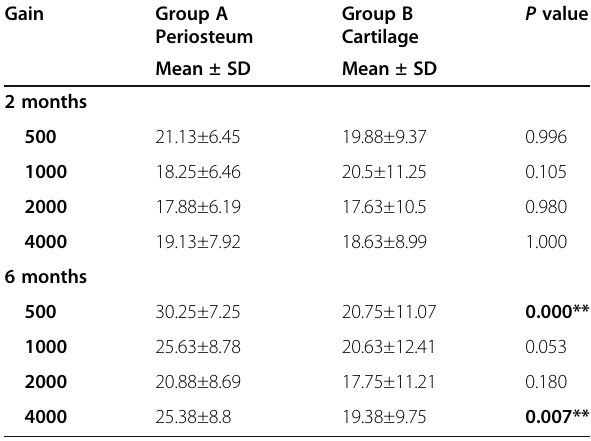
Table 4 Two- and six-months hearing